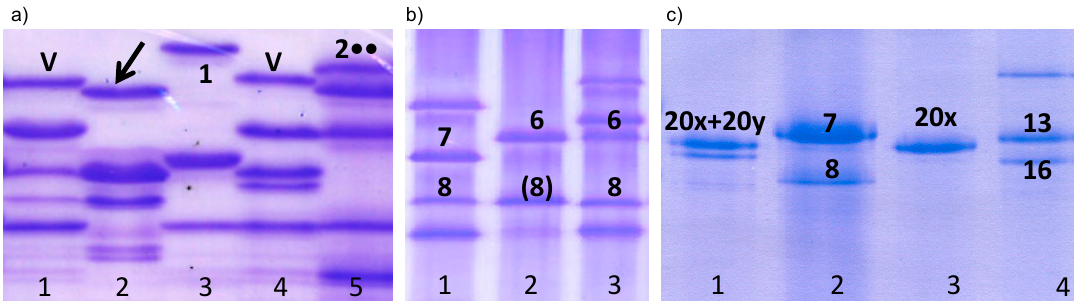
Figure 1. Electrophoretic patterns of durum wheat landraces and standard varieties illustrating some of the high molecular weight glutenin subunits (HMW-GS) observed in the accessions under study. ( a ) Lanes 1–5 show the subunits encoded by the Glu-A1 locus in accessions BGE018295, BGE019307 (new subunit), BGE013104 and BGE018273, and in the standard bread wheat ‘Ribeiro’, respectively. The HMW-GS not previously described is indicated by an arrow. ( b ) Prolamin bands encoded by the Glu-B1 locus in the bread wheat standards for the subunit pairs 7 + 8 (‘Chinese Spring’, lane 1) and 6 + 8 (‘Hope’, lane 3) and in one durum wheat accession with the By(8) subunit (BGE-018315, lane 2). ( c ) Lanes 1–4 show the subunits encoded by the Glu-B1 locus in ‘Federation’, ‘Chinese Spring’, landrace BGE021769 (Bx20 subunit) and ‘Lancota’, respectively.